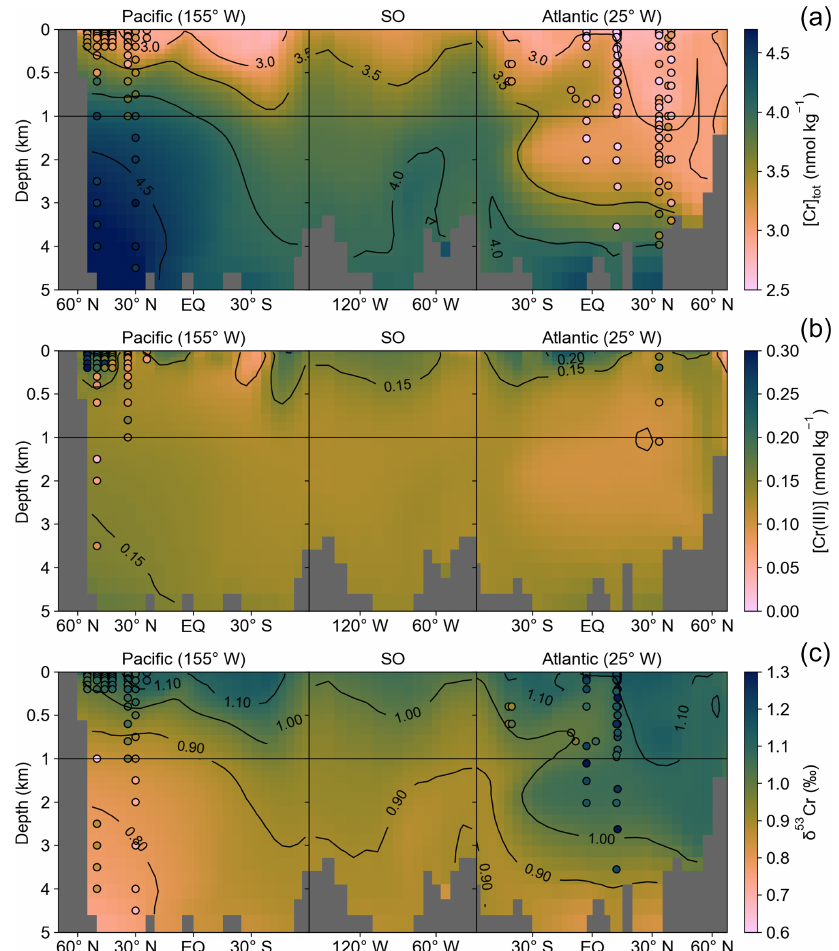
Figure 5. (a) Total dissolved Cr concentrations along the transect marked in Fig. 1 from the North Pacific via the Southern Ocean (SO) to the North Atlantic. Filled circles are seawater observations on the same color scale as the model data. (b) Dissolved Cr(III) distribution along the same transect as in (a) . (c) Calculated δ 53 Cr distribution based on the global ocean array assuming δ 53 Cr =− 0 . 70 · ln([Cr] tot ) + 1.86 (Janssen et al., 2021) compared to observational isotope ratio data. Only observational seawater data close to the transect ( ± 15 ◦ ) are shown. Note the different y scales for the top